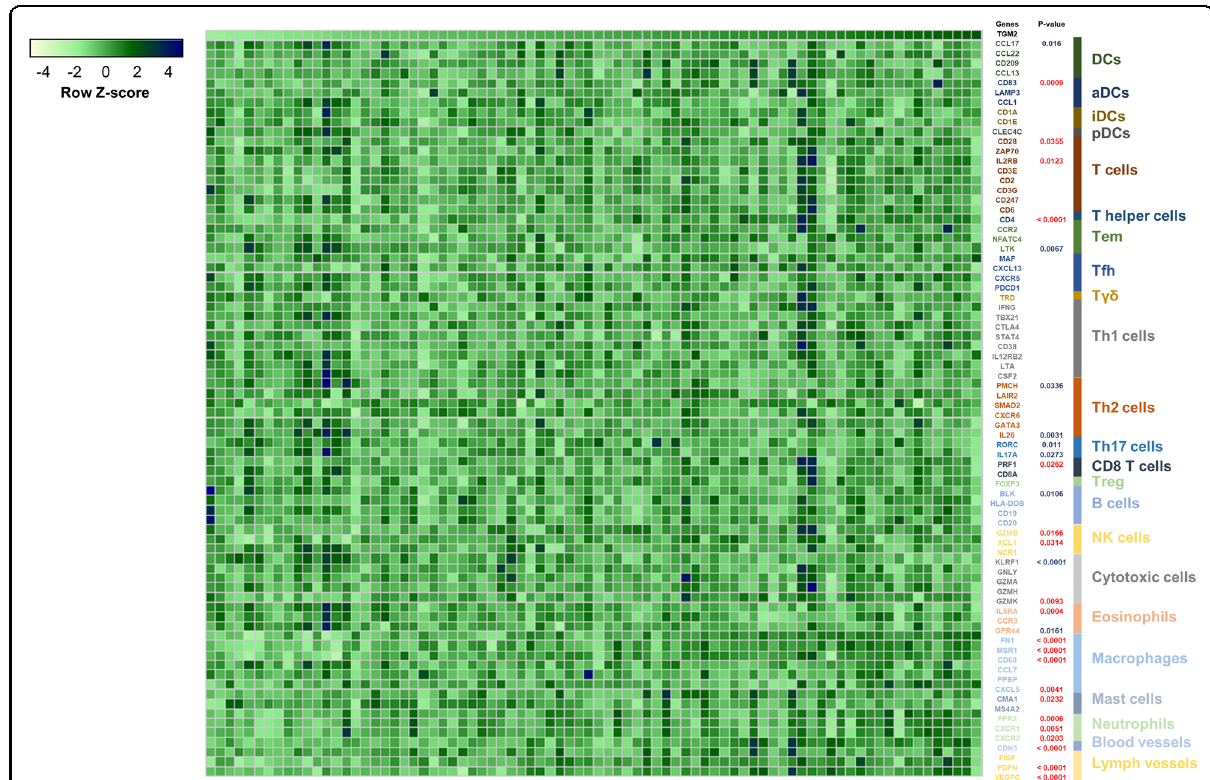
Fig. 4 Correlations between TGM2 expression and immune cell type-speci fi c gene expression in 80 gastric cancer tissue specimens. Microarray data were downloaded from Gene Expression Omnibus (GEO; GSE27342), and the heatmap represents the matrix of gene expression of TGM2 and 76 immune cell type-speci fi c genes representing 23 cell types, which are shown in colored gene names and bars (right). Each column represents an individual GC sample, and each row denotes a gene. The correlation between TGM2 expression and immune cell type-speci fi c gene expression was estimated by linear regression analysis, and the P -values for genes that were signi fi cantly correlated with TGM2 expression are depicted ( P < 0.05; red: positive correlation, blue: negative correlation). DCs dendritic cells, aDCs activated DCs, iDCs immature DCs, pDCs plasmacytoid DCs, Tem effector memory T cell, Tfh follicular helper T cell, T γδ gamma delta T cell, and Treg regulatory T